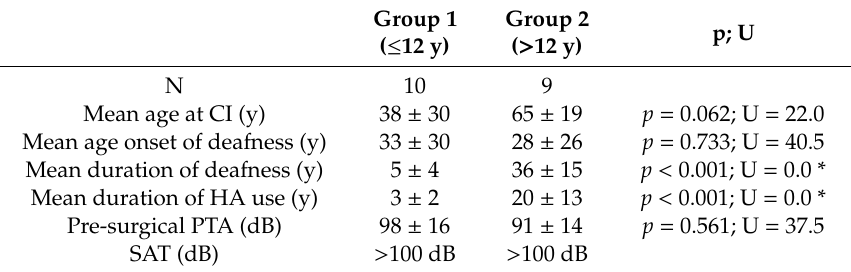
Table 1. Characteristics of the patients grouped according to the median duration of deafness (12 years).